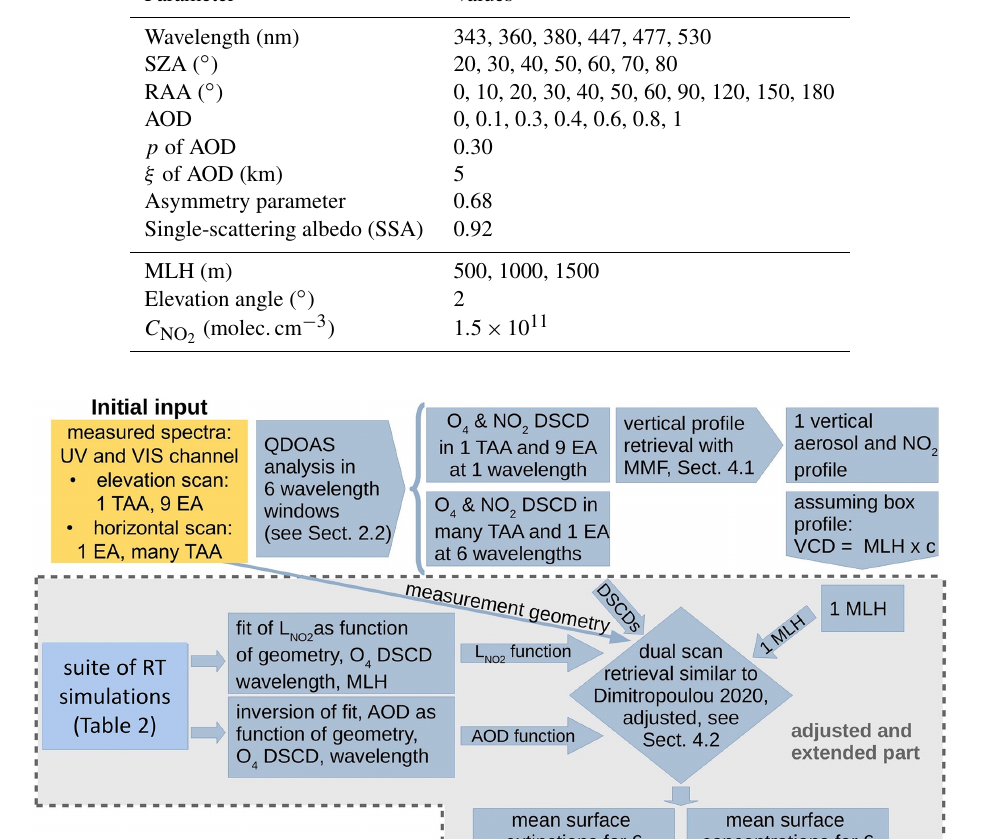
at the six selected wavelengths (343, 360, 380, 447, 477, and 530nm). 2